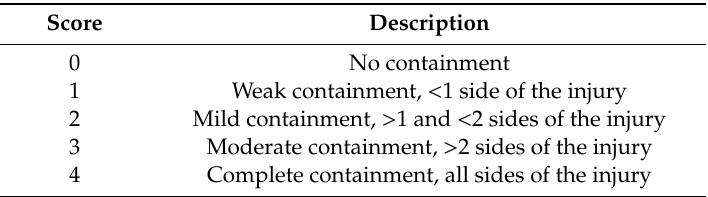
Table 5. Degree of containment